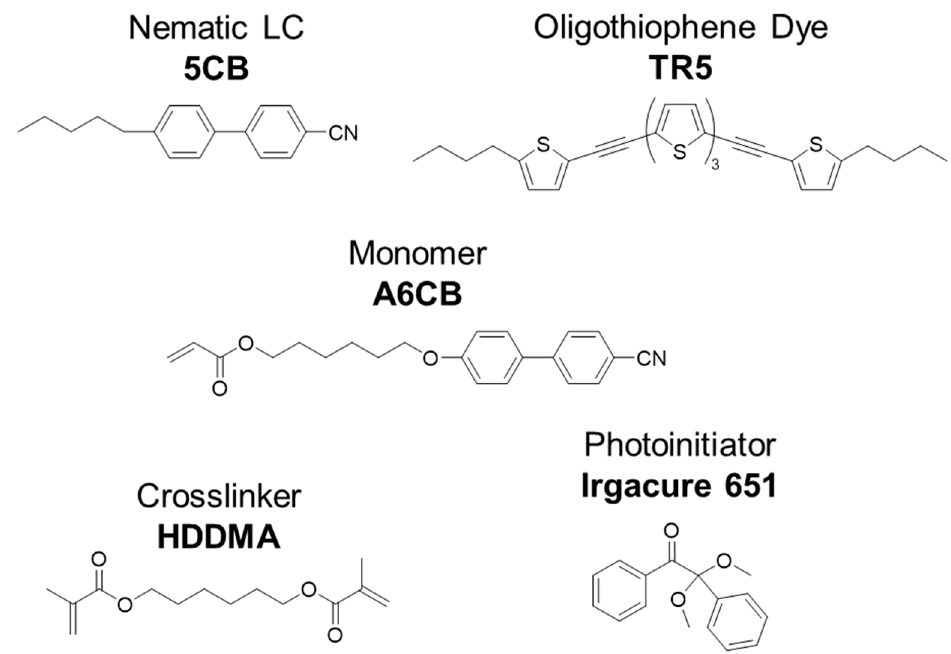
Figure 1. Chemical structures of the compounds used in this study.